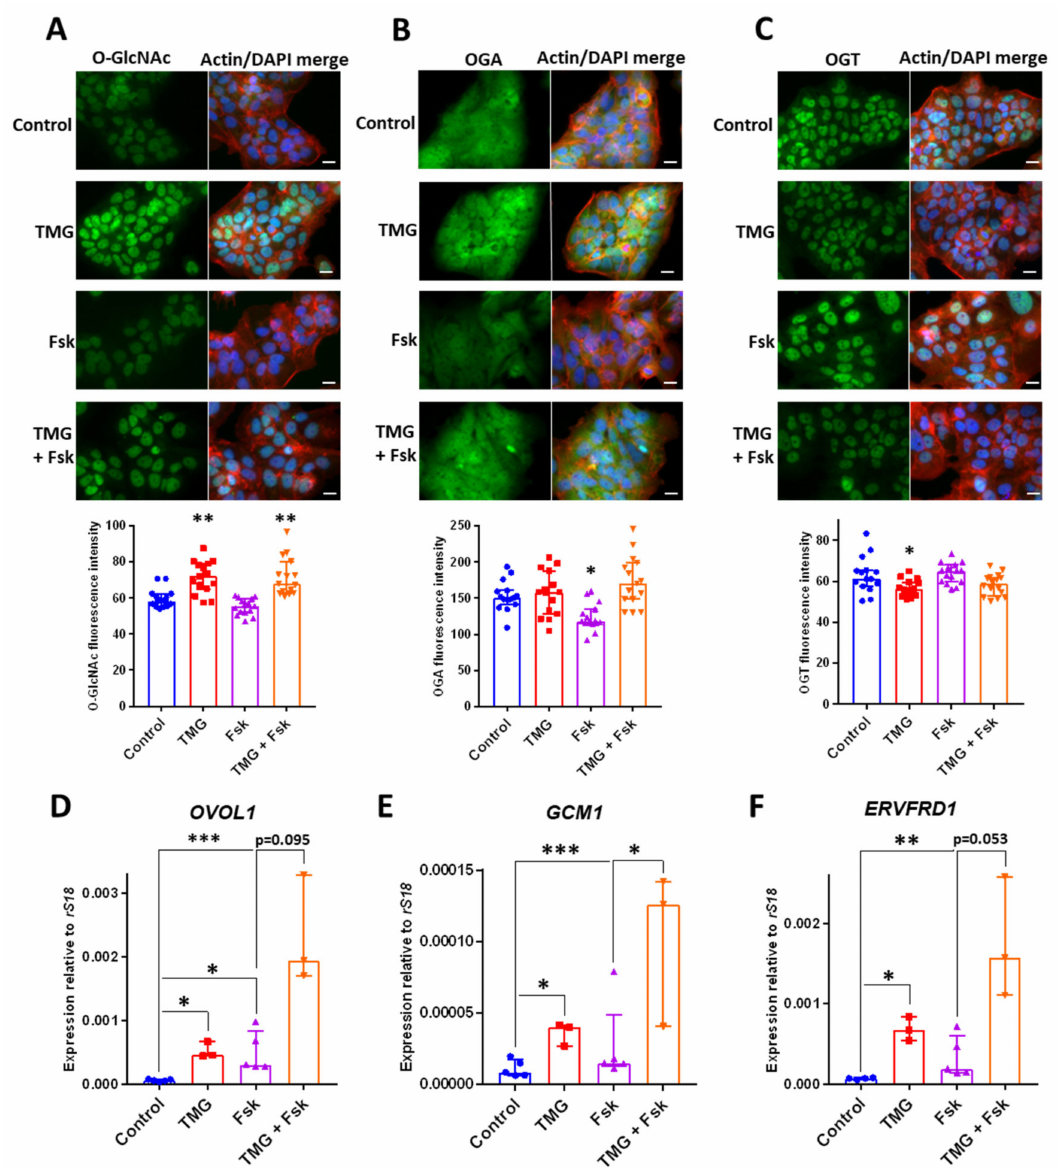
Figure 4. BeWo cells were treated for 24 h with DMSO (forskolin vehicle control), treated with 5 µ M TMG and DMSO for 24 h, treated with 50 µ M forskolin (Fsk) for 24 h, or treated with 5 µ M TMG and 50 µ M Fsk. ( A – C ) BeWo cells were immunostained with phalloidin (red), DAPI (blue) and ( A ) anti-O-GlcNAc antibody (green), or ( B ) anti-OGA antibody (green), or ( C ) anti-OGT antibody (green). Quantification of O-GlcNAc, OGA and OGT immunostaining mean fluorescence intensity (arbitrary units) is shown ( n = 15 fields of view from three independent experiments, median ± IQR; * p < 0.05 ** p < 0.01 Control vs. TMG; Kruskal–Wallis). ( D – F ) qPCR was performed on BeWo cells to determine the expression of ( D ) OVOL1, ( E ) GCM1 and ( F ) ERVFRD1 ( n = 3–5; median ± IQR; * p < 0.05; ** p < 0.01; *** p < 0.001;